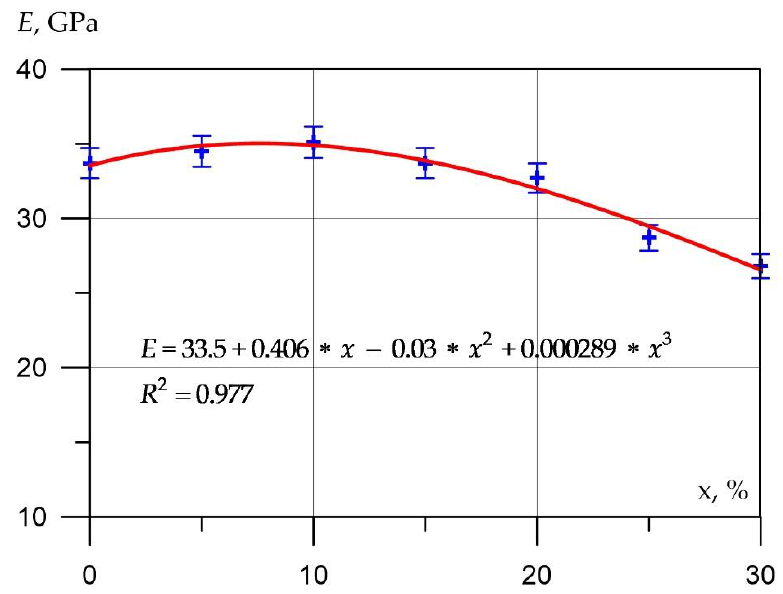
Figure 6. The dependence of the modulus of elasticity of concrete on the amount of eggshell powder.